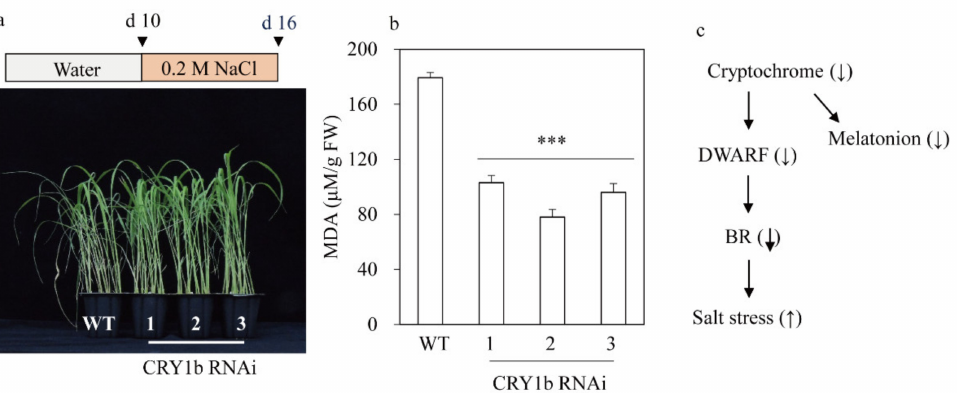
Figure 6. Effects of salt treatment on CRY1b RNAi rice plants. ( a ) Photograph of representative phenotypes after salt treatment. ( b ) Malondialdehyde (MDA) levels in WT and transgenic rice plants. ( c ) Proposed model of CRY-mediated salt tolerance. Values are presented as the means ± SDs of three independent experiments. FW, fresh weight; d, day. *** p < 0.001, Tukey’s HSD post-hoc